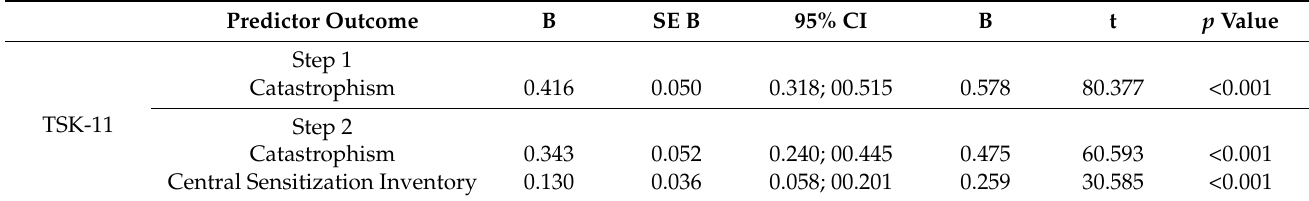
Table 3. Summary of the stepwise regression analyses to determine predictors of